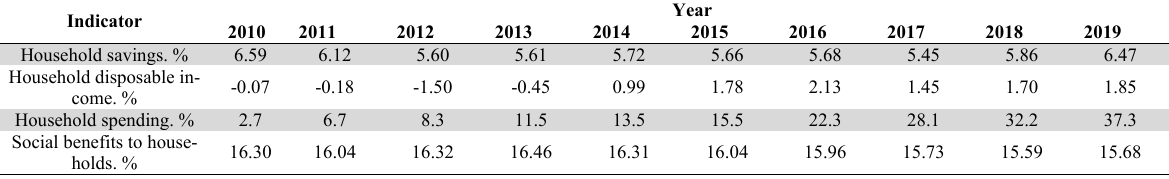
The indicators influencing on food security